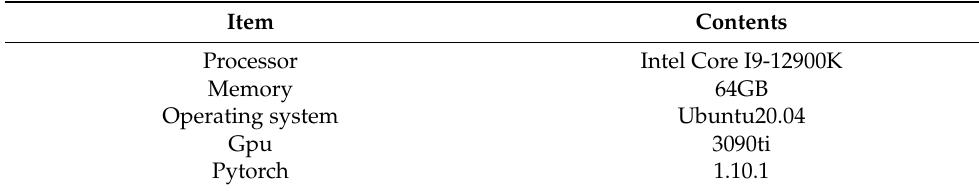
Table 1. Experimental equipment